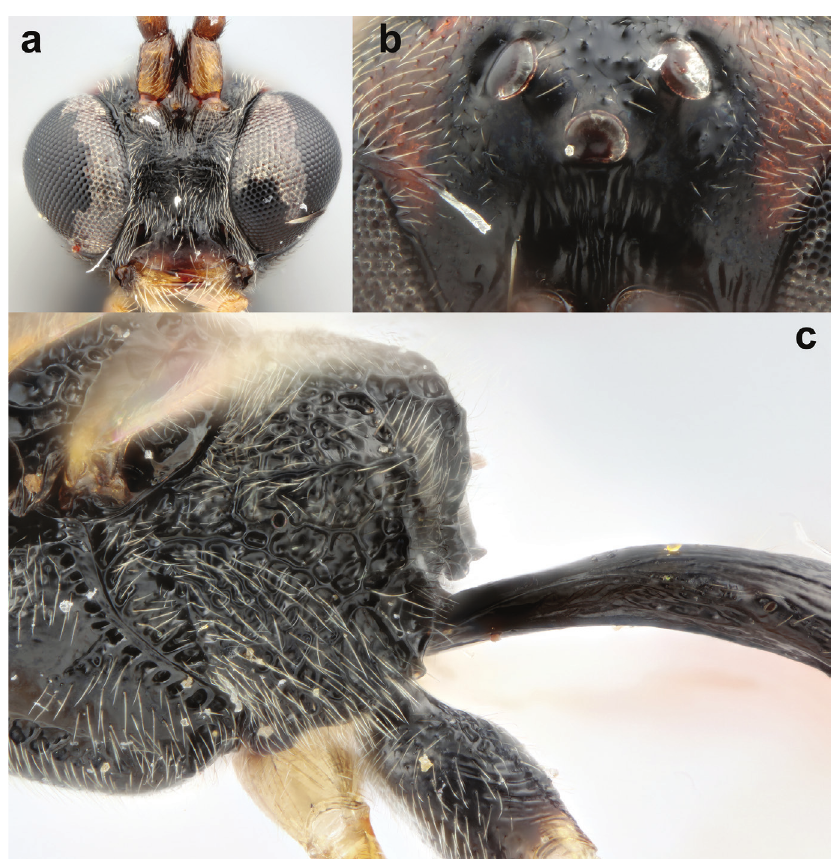
Figure 3. Details of Orionis coxator (NHMUK014425411) a head in frontal view b frons and upper head c propodeum, first metasomal segment and hind coxa in dorsolateral view.